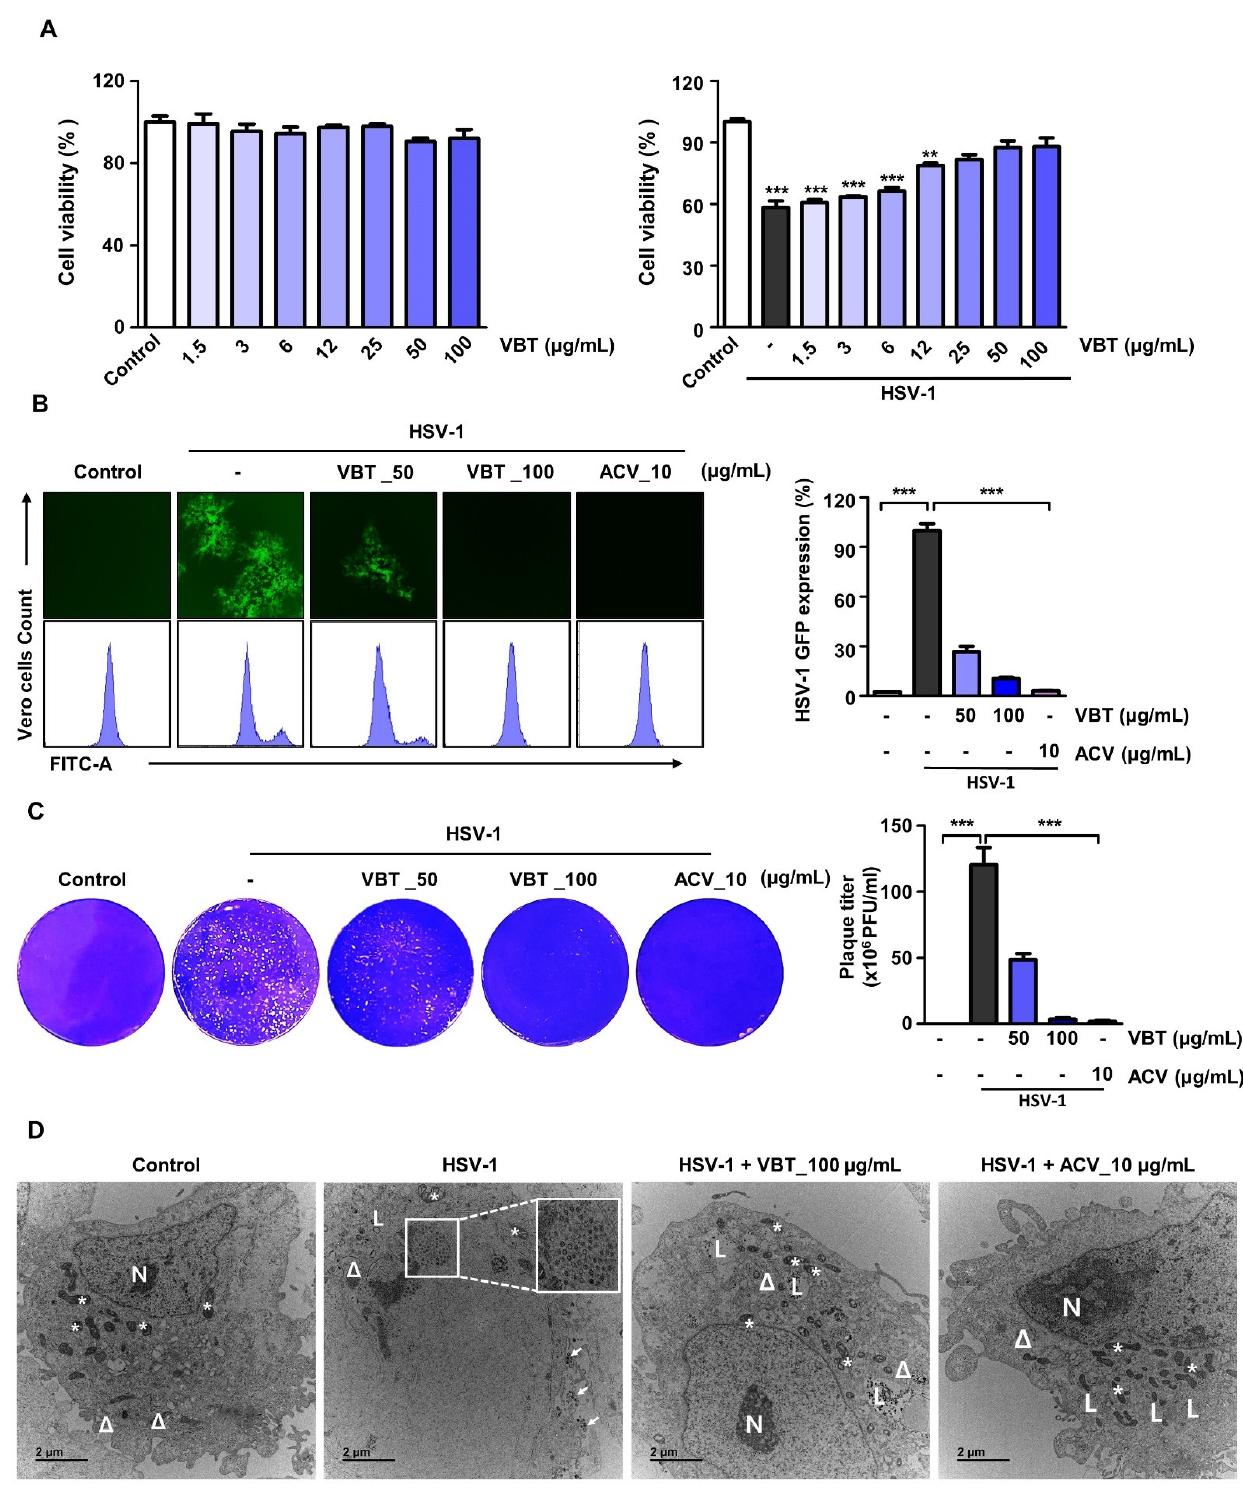
Figure 1. Anti-HSV-1 activity of VBT in Vero cells . ( A ) Vero cells were treated with VBT at the indicated concentrations and incubated for 48 h ( Left ). VERO cells were infected with HSV-1 (MOI = 0.1) for 2 h, then replaced with fresh medium, treated with VBT at the indicated concentration, and incubated for 48 h ( Right ). Cell viability was measured using CCK-8 assays. ( B ) Vero cells were infected with HSV-GFP (MOI = 2) for 2 h, then the medium was replaced with fresh medium, and